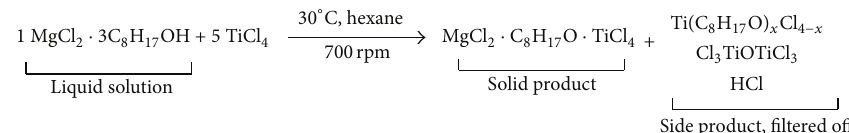
Scheme 1: Synthesis of the magnesium supported Ziegler-Natta